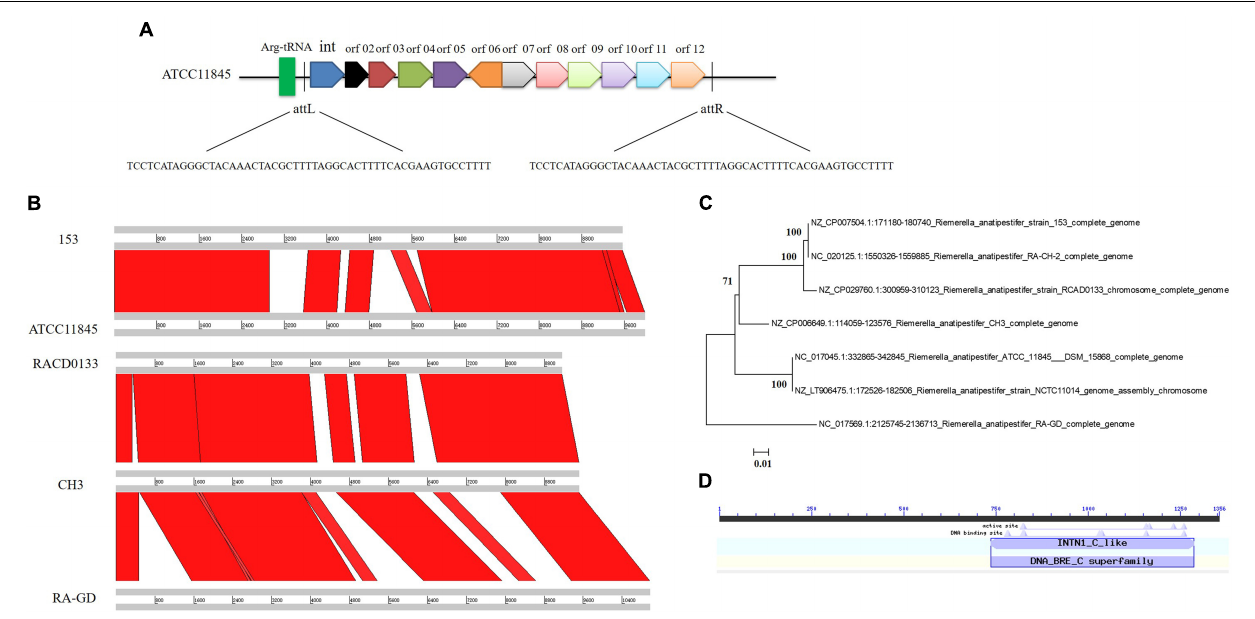
FIGURE 1 | 10K genomic island in Riemerella anatipestifer. (A) Analysis of the 10K genomic island related genes in R. anatipestifer. The 7 R. anatipestifer GIs sequence were compared (B) and phylogenetic tree was constructed containing 7 10K GI sequences (C) . (D) Bioinformatics analysis the conserved domain of integrase in 10K genomic